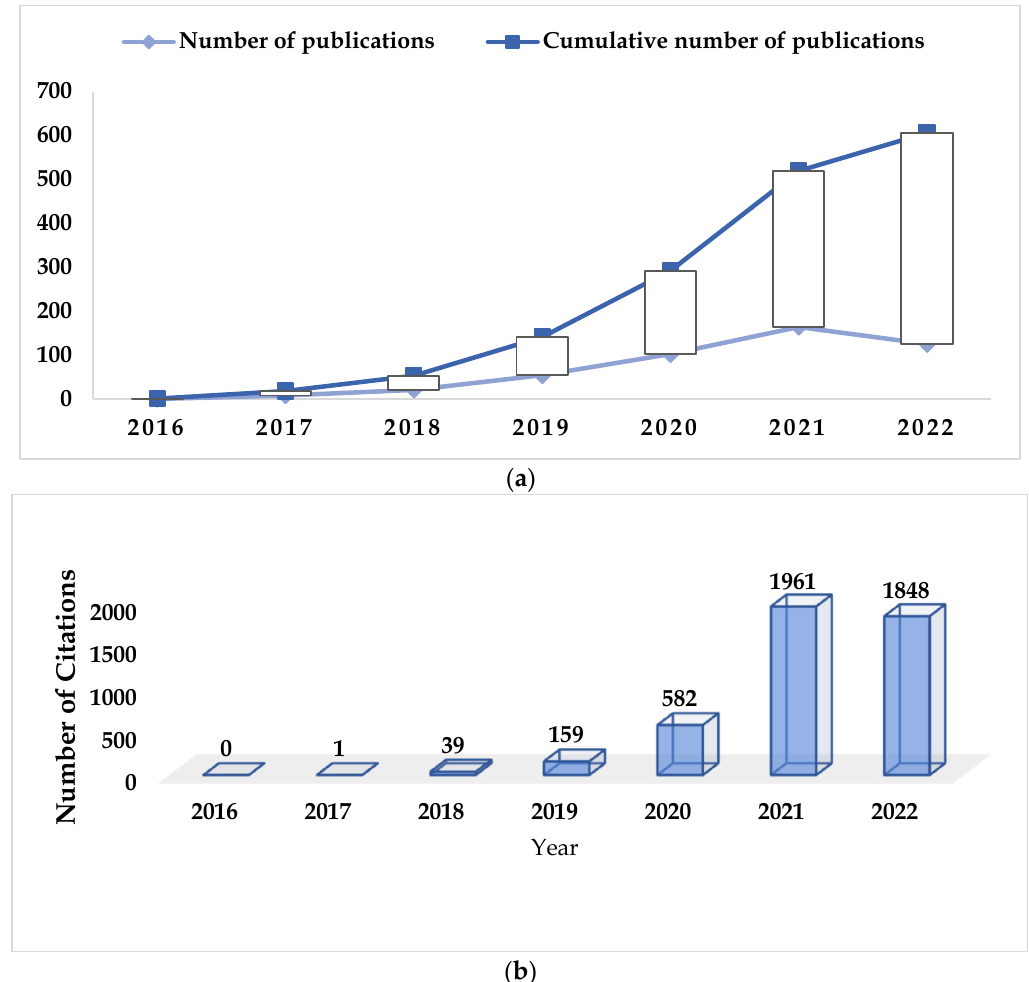
Figure 4. ( a ) Number of publications from 2016 to 2022; ( b ) Number of citations from 2016 to 2022. Table 2. The most productive